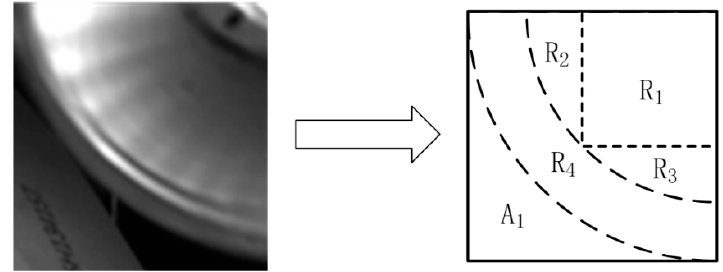
Figure 4. Composition of the mechanical wheel target component.